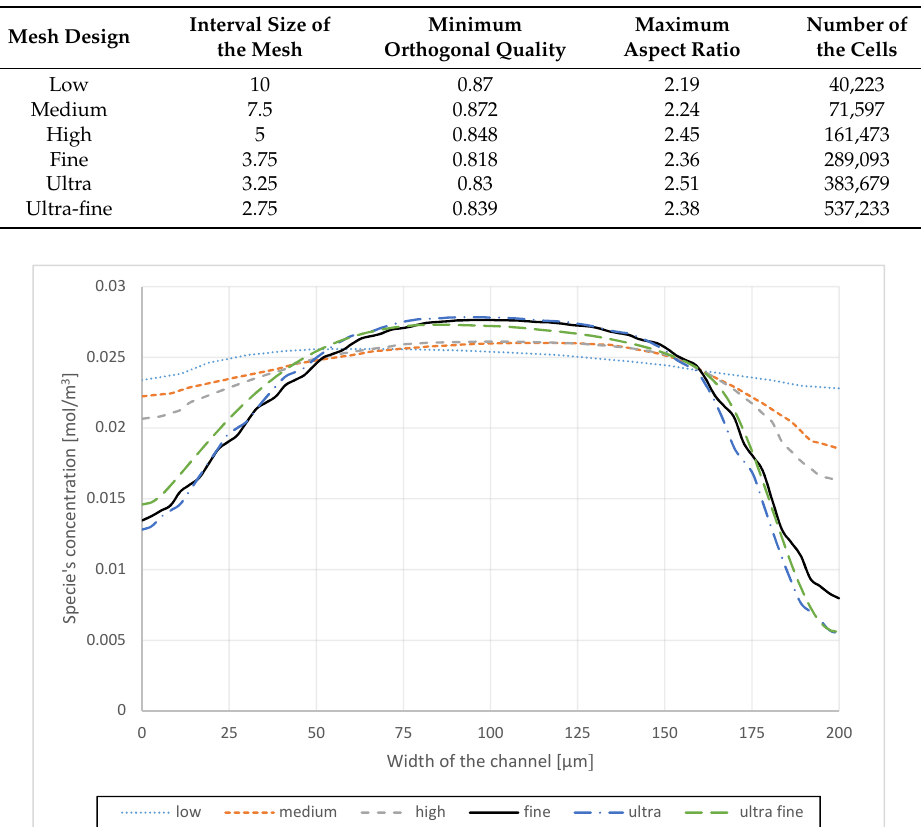
Figure 2. Distribution of the species concentration over a cross-section at the outlet of a simple one loop spiral micro mixer obtained from different